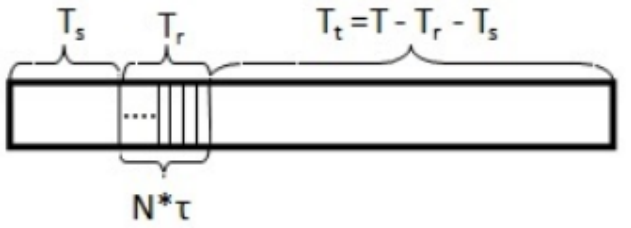
Figure 1. Cooperative spectrum sensing in a cognitive vehicular network. The wireless links between the PU and SVUs are referred to as the sensing channels, whereas the links between the SVUs and FC are the reporting channels.